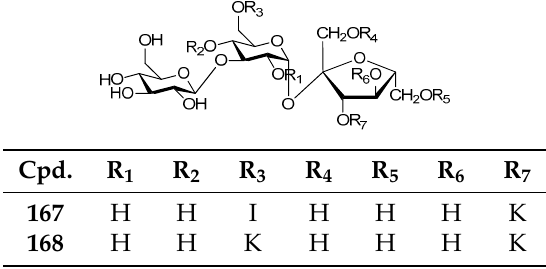
Figure 17. Structures of compounds 163 – 166 .